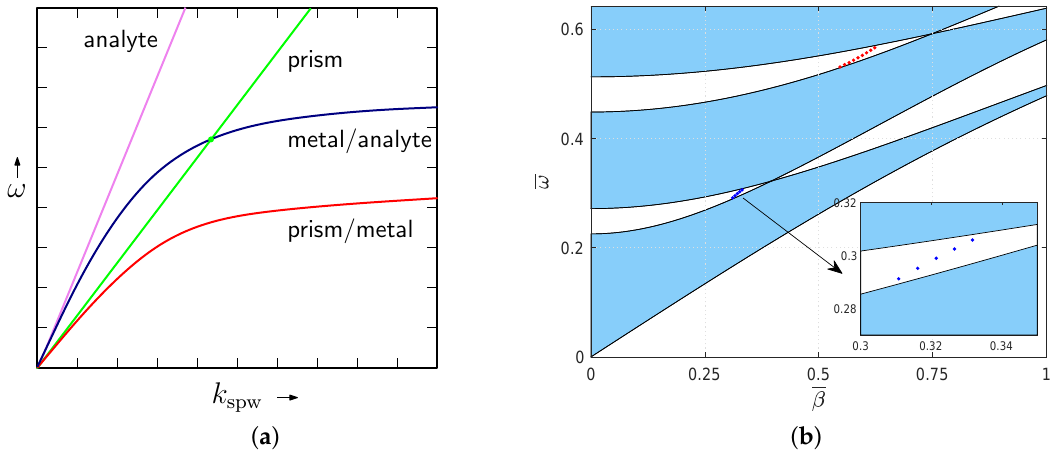
Figure 2. Dispersion of the wavevectors of the light wave in air (violet line) and in the glass prism (green line), the SPP waves at the metal/air interface (blue line), and the prism–metal interface (red line), respectively ( a ); the computed band structure of an infinite periodic MDS for the TM wave ( b